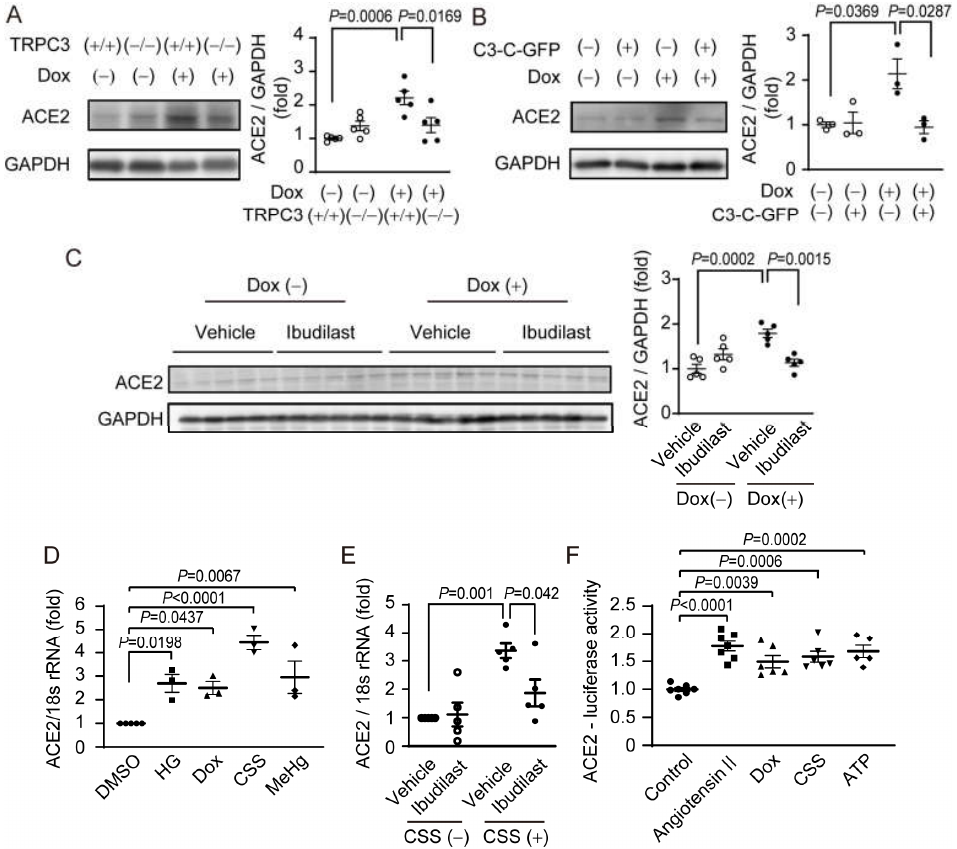
Figure 2. Involvement of TRPC3-Nox2 protein complex formation in pathological ACE2 upregulation in rodent hearts and cardiomyocytes. ( A – C ) Expression of ACE2 proteins in Dox-treated TRPC3(+/+) and TRPC3( − / − ) mouse hearts ( A ), Dox-treated mouse with cardiomyocyte-specific expressing GFP-fused inhibitory peptide (C3-C) against TRPC3-Nox2 interactions ( B ), and Dox-treated mice with ibudilast (10 mg/kg/day) or vehicle ( C ). ( D , E ) ACE2 mRNA expressions in NRCMs exposed to several cardiac risk factors for 24 h. HG: high glucose (25 mM); Dox: doxorubicin (1 µ M); CSS: cigarette sidestream smoke-containing medium (1%); and MeHg (500 nM). ( E ) Effect of ibudilast (10 µ M) on CSS-exposed increase in ACE2 mRNA expression. ( F ) ACE2 transcription activities in NRCMs treated with Ang II (1 µ M) and ATP (1 mM) for 24 h. All data are shown as mean ± SEM; n = 3–8. Significance was imparted using two-way ANOVA and one-way ANOVA followed by Tukey’s comparison